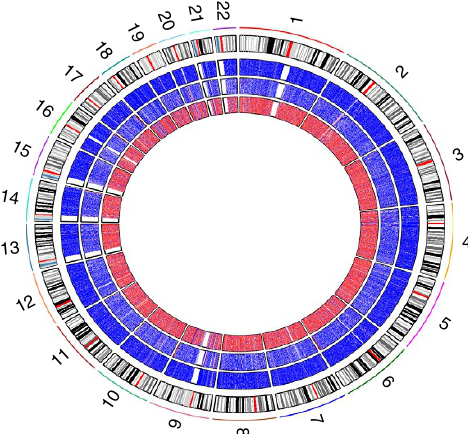
Figure 2 | Heritability of DNA methylation level across the genome. Estimates of DNA methylation heritability from the GRM-based approach in 2,603 individuals. From inside to outside: the most inner circular diagram displays the average methylation level at each site, the second band shows the total heritability of DNA methylation level, the third band shows the SNP heritability of DNA methylation level, and the most outer circle shows the chromosome ideograms. Colours range from dark blue (0%) to dark red (100%).